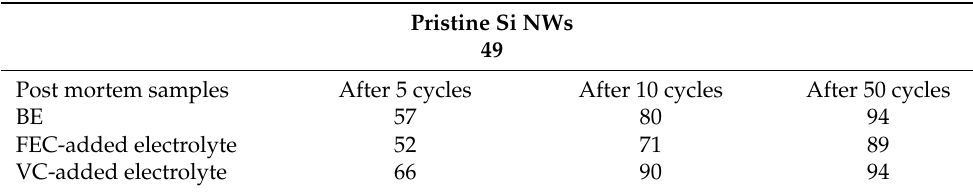
Table 1. Mean values of the amorphous fraction (in %) for the four samples obtained from the analysis of the Raman maps shown in Figure